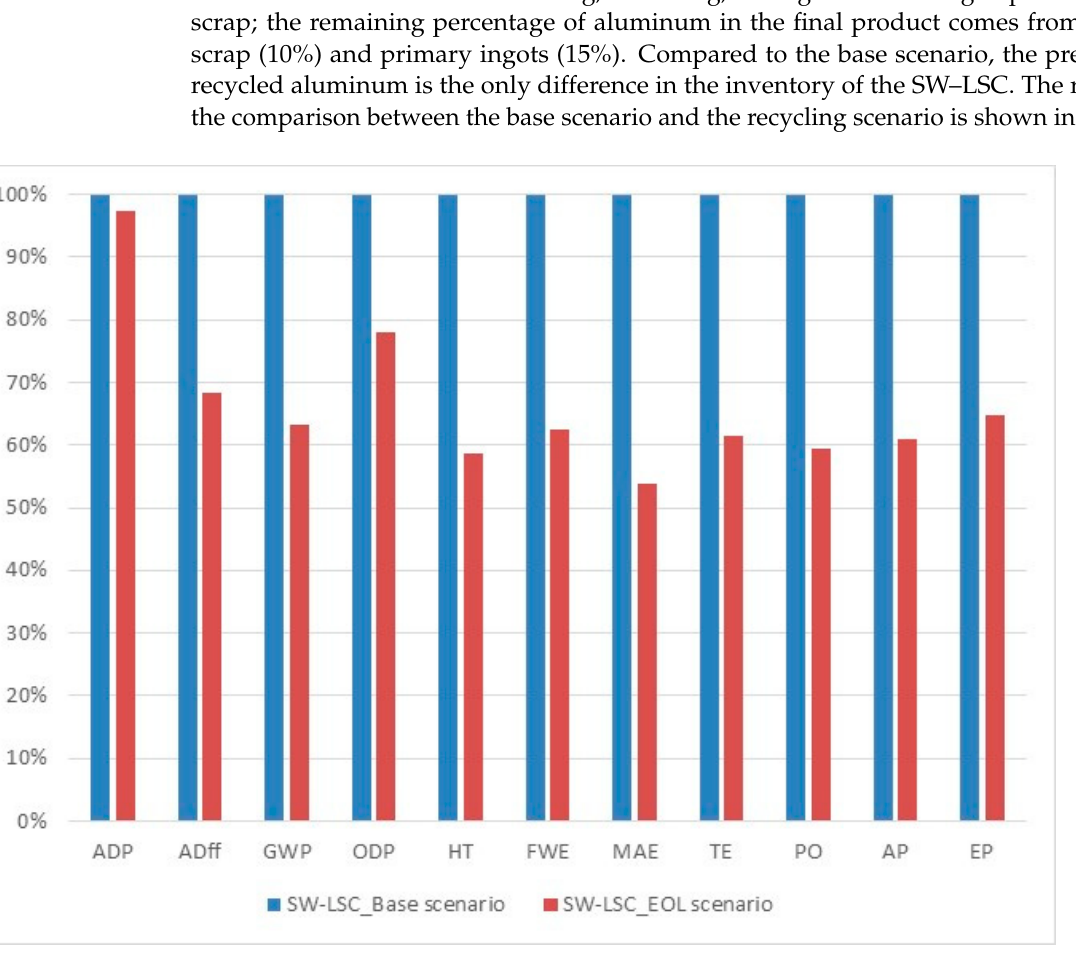
Figure 5. Comparison between Base scenario and Recycling (EOL) scenario for the SW–LSC.